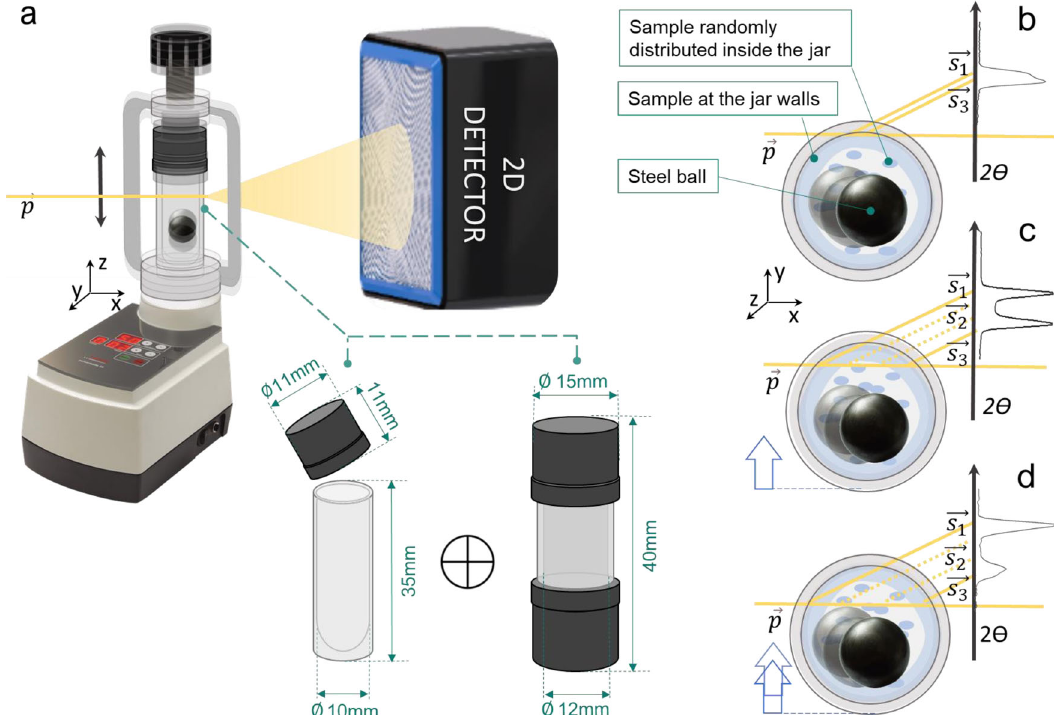
Fig. 1 Schematic representation of the milling setup used in this study. The PMMA jars are used with the Fritsch Pulverisette 23 ( a ). The primary X-ray beam ~ p (yellow line) passes through the jar and is diffracted by the sample contained within (light blue). Two different jars were developed (see Supplementary Note 2 for details), made from PMMA (transparent) and PVC (black) or stainless steel caps. The jar used for Reactions I – III is 12 mm internal diameter and comprises 0.75 mm walls, whereas the jar used for Reaction IV is 10 mm internal diameter with 0.5 mm walls. Diffraction with this setup results in splitting of each Bragg re fl ection into a convolution of 2 θ positions ( b – d ), as the powder inside the jar is distributed across different locations and hence a range of sample-to-detector distances. Thus, the measured scattering vectors are markedly offset when the jar is investigated in a general position with respect to the primary beam ( c , d ) and can be minimised with accurate jar alignment ( b ).